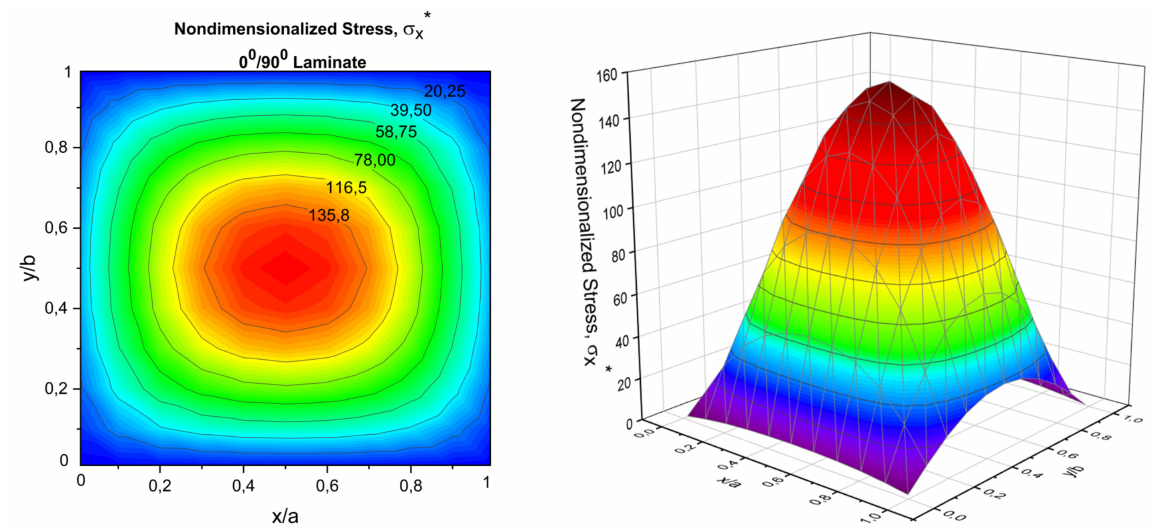
Figure 12. Variations of the non-dimensional stresses, σ x ∗ , of a moderately thick ( a / h = 20) shell panel (R/ a = 10) and of antisymmetric [0 ◦ /90 ◦ ] cross-ply spherical panels along the panel